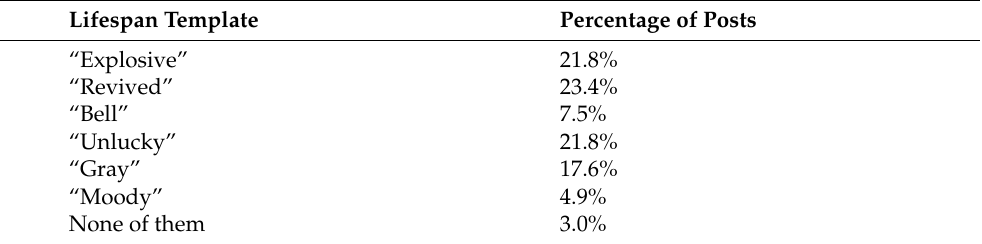
Table 10. Distribution of the posts of the second dataset against lifespan